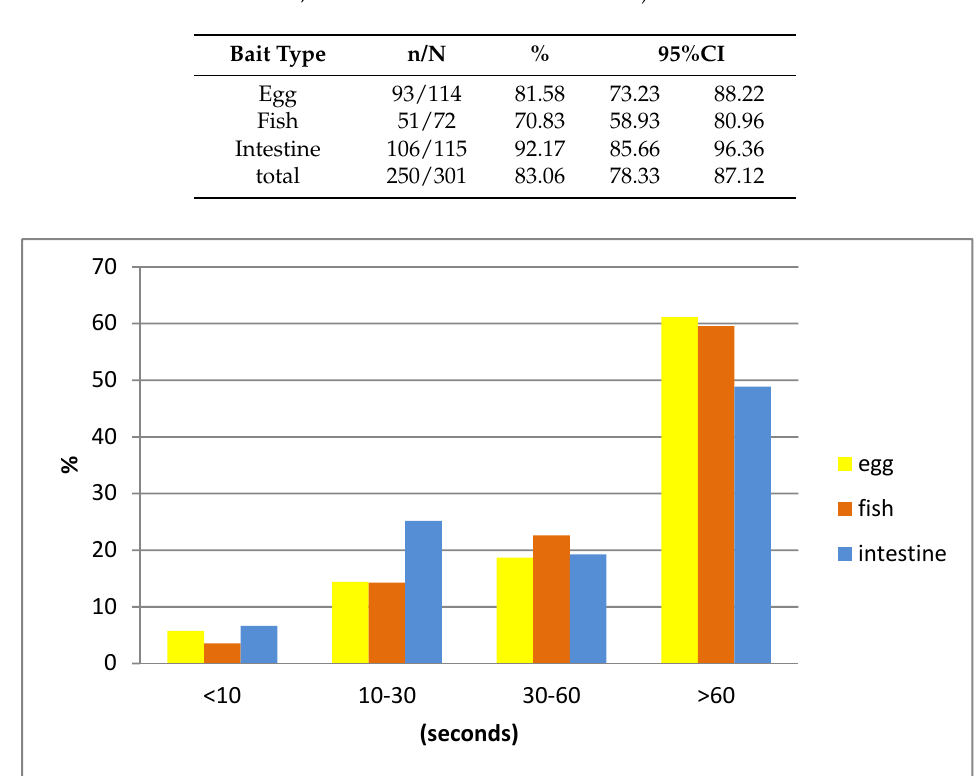
Figure 4. Bait handling time (seconds) for the three different baits.